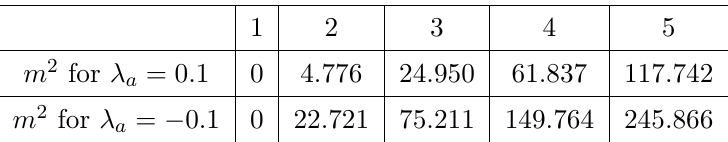
Table 2 . Mass spectrum for d = 4